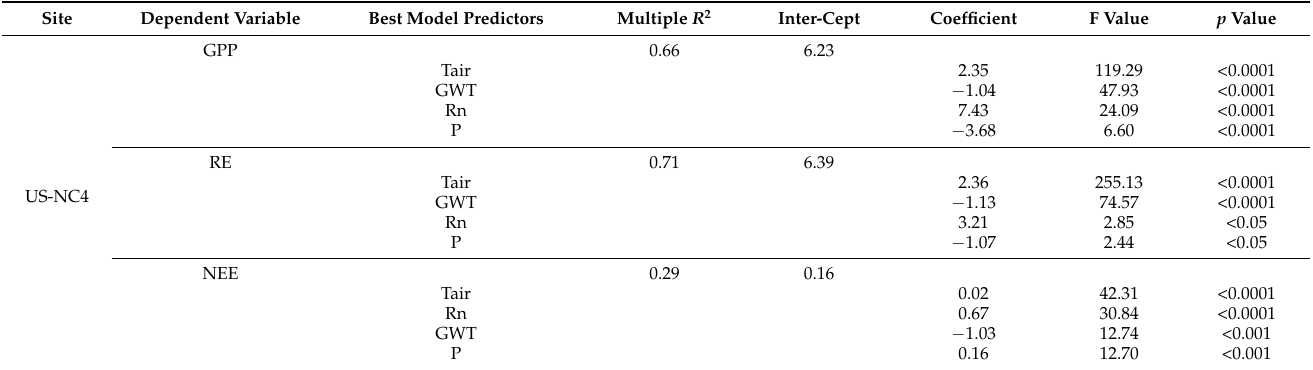
Table 2. Results of generalized additive modeling (GAM) analysis to detect the best models and rank predictor variables e.g., air temperature (Tair), net radiation (Rn), groundwater table depth (GWT), and Precipitation ( p ) according to their ability to explain variation in gross primary productivity (GPP), ecosystem respiration (RE), and net ecosystem exchange (NEE). Daily data from 2009–2019 were used in the analysis. In order to avoid model over-parameterization, the second-order Akaike information criterion was used to determine the best smoothing dimension with an upper limit equal to 3. We report the coefficient of the fitted model with values for each spline term in turn. Site Best Model Predictors Multiple R 2 Inter-Cept F